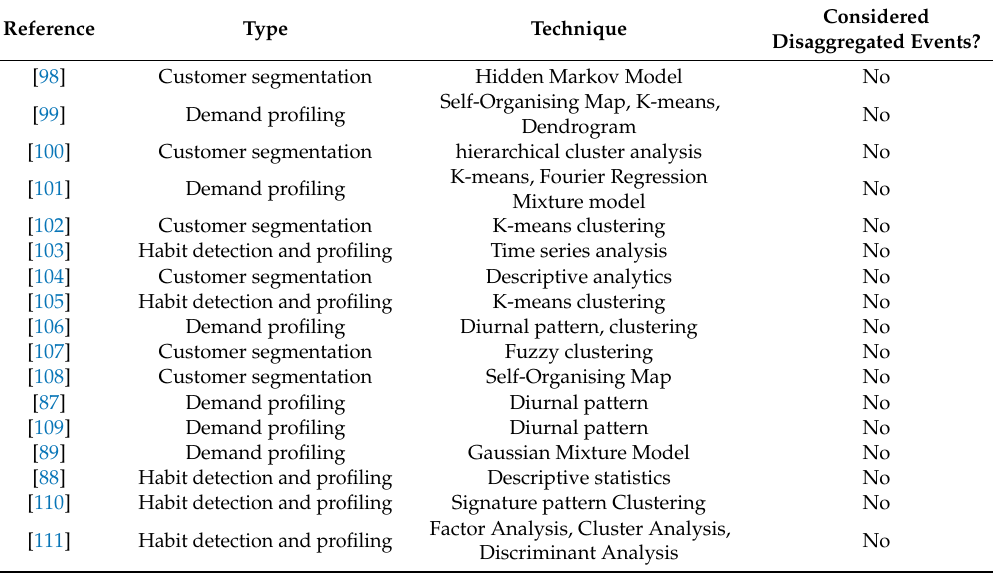
Table 5. Findings from the studies on behaviour